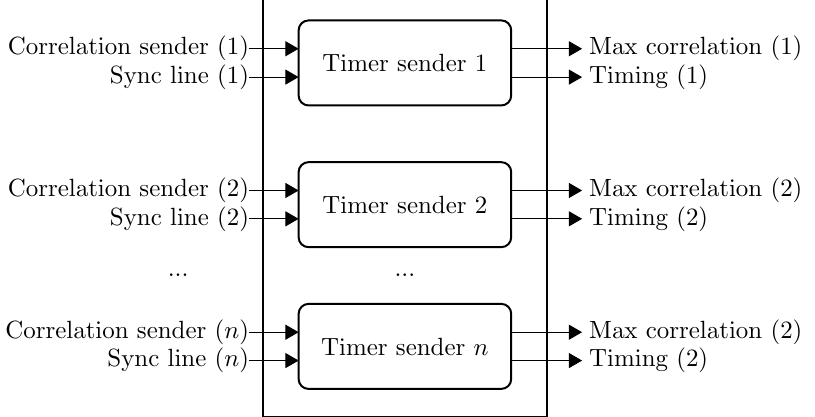
Figure 10. Timing module. Each of the submodules calculates the distance relative to one transmitter and the best achieved